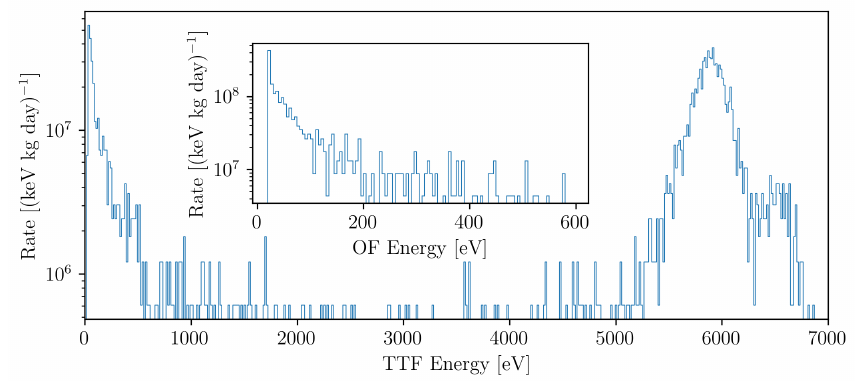
Figure 8: Final energy spectrum of the NUCLEUS-1g-prototype 2017. Main frame: complete energy range up to the 55 Fe calibration lines, reconstructed with the trun- cated template fit (TTF). Inset: zoom on the low-energy region (19.7 eV - 600 eV), reconstructed with the optimum filter (OF). Figure from Ref. [ 47 ]